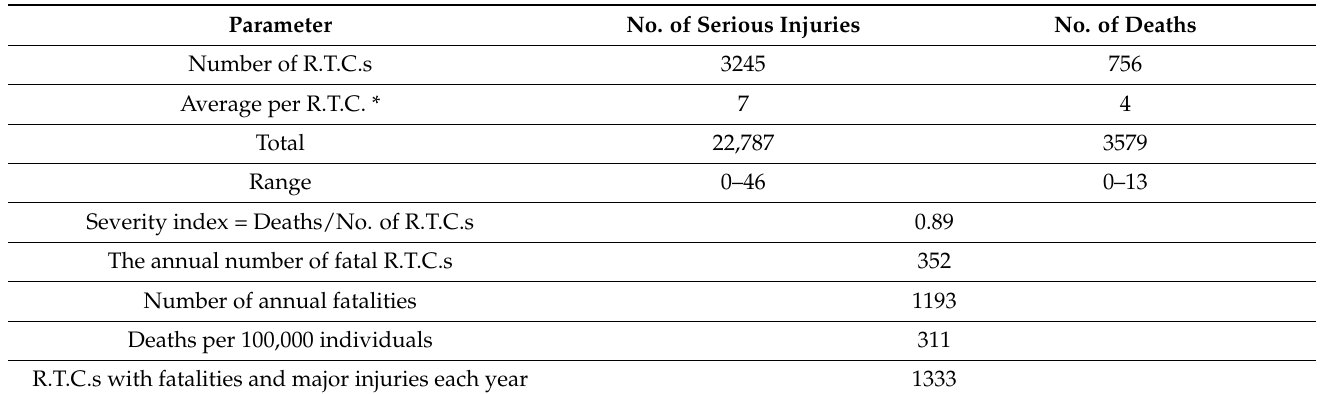
Table 1. Statistics on serious injuries and fatalities in the study area (adopted from [65]). Parameter No. of Serious Injuries Number of R.T.C.s Average per R.T.C.